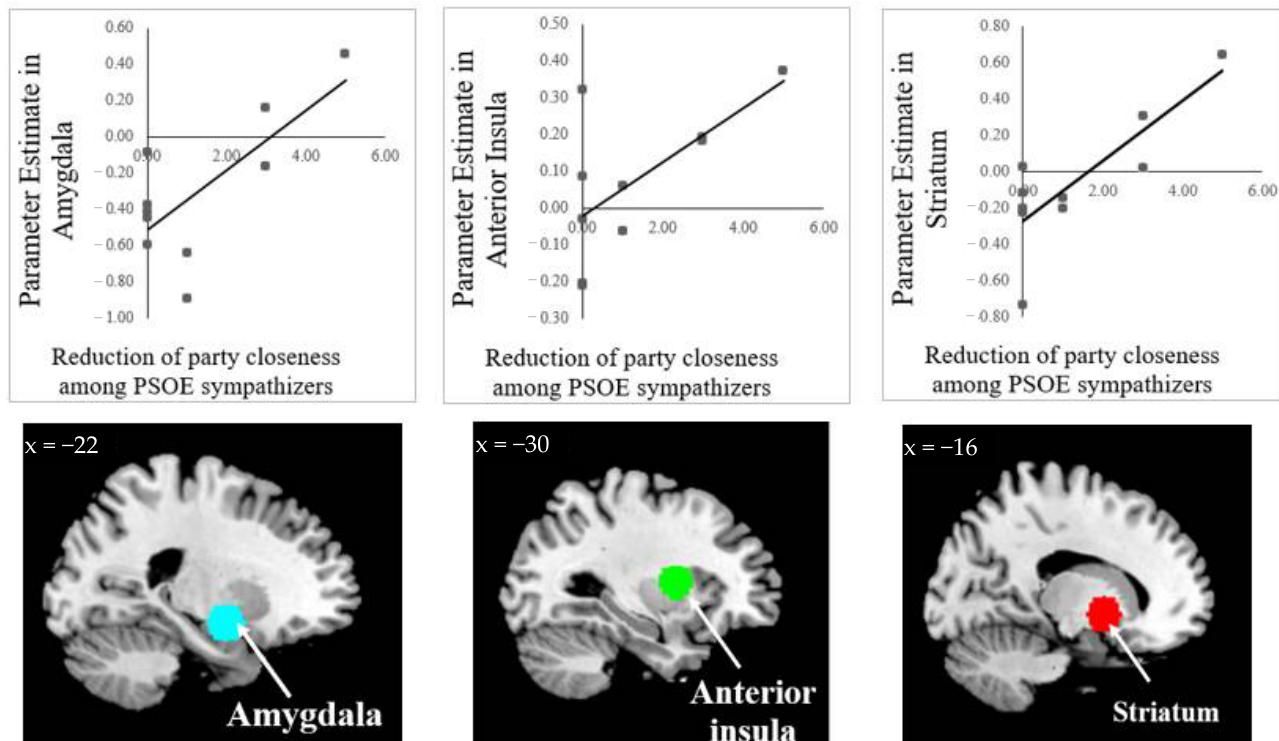
Figure 2. Illustration of the regions of interest taken as 10-mm spheres and their correlation to changes of party closeness. (Blue): amygdala (Westen et al., associated with incongruent processing [44]); (Green): anterior insula (Chua et al., related to disappointment [60]); (Red): striatum (Bartra et al., involved with emotional negative processing [46]). Table 1. Brain regions resulting from the small volume correction (e.g., SVC, whole-brain with mask) and whole-brain (with- out mask) analyses associated with party closeness change among Spanish Socialist Workers’ Party (PSOE) sympathizers. Peak MNI Coordinates (mm) Contrasts and Regions